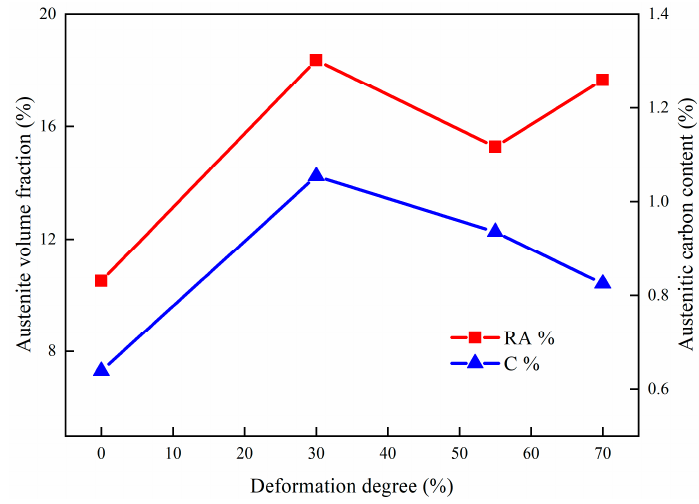
Figure 3. Variation in retained austenite and carbon content after different degrees of deformation.